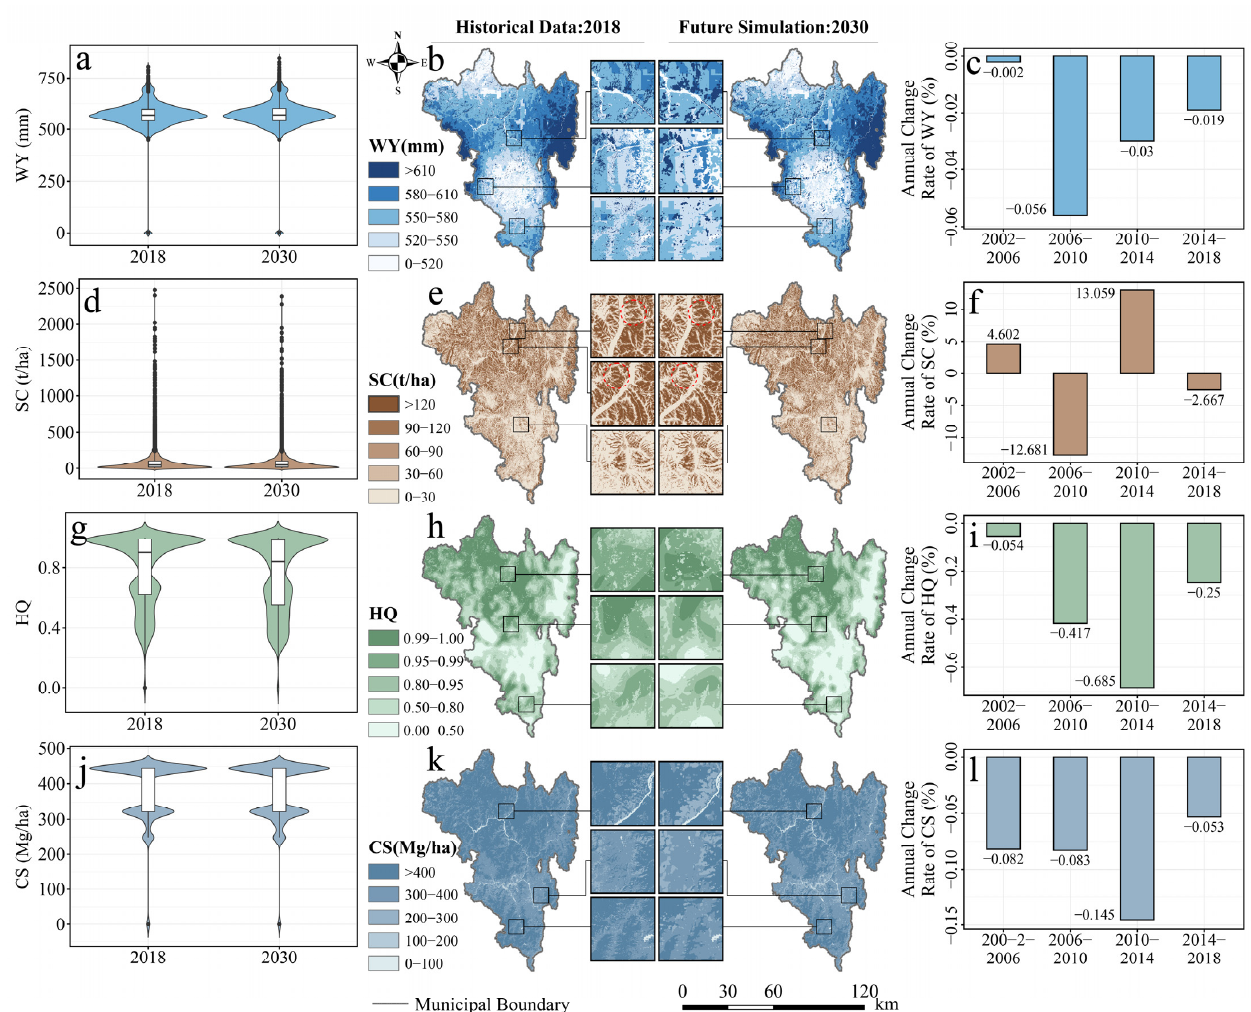
Figure 4. Spatial and temporal distribution and annual change rates of ecosystem services from 2002 to 2030: ( a – d ), ( e – h ), and ( i – l ) are the overall pixel distribution, spatial distribution, and annual change rate of WY, SC, HQ, and CS, respectively. Note: WY: water yield; SC: soil conservation; HQ: habitat quality; CS: carbon storage.